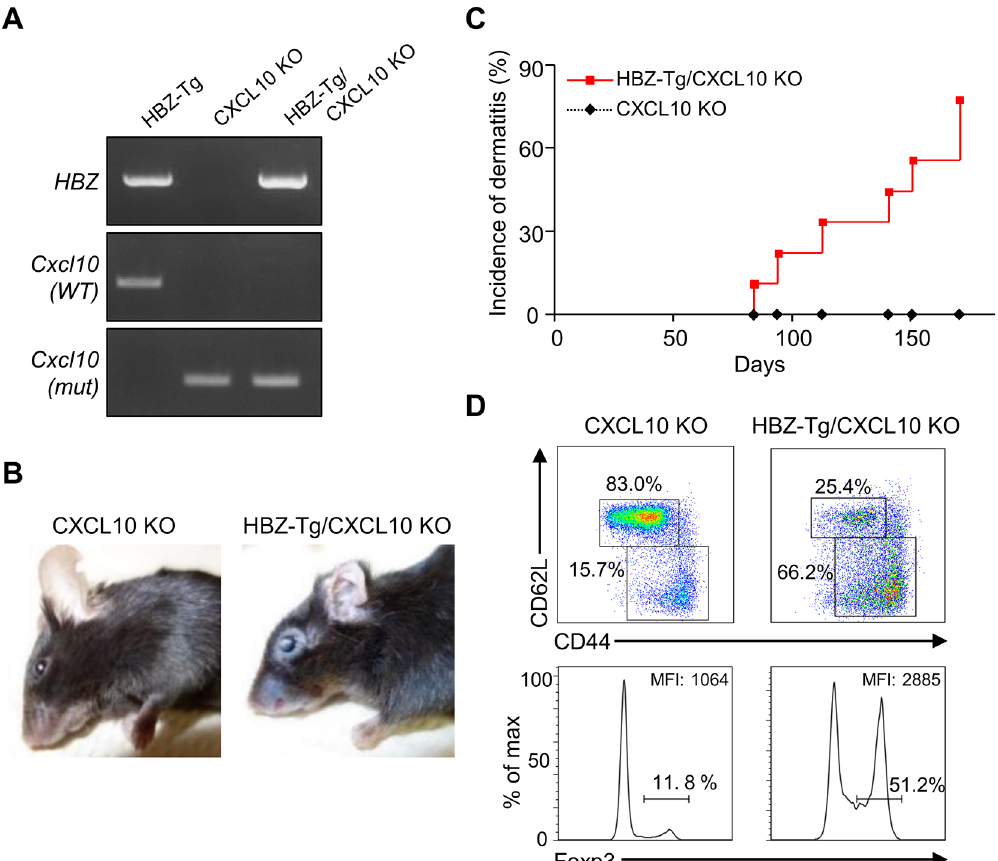
Fig 5. CXCL10 is not associated with systemic inflammation in HBZ-Tg mice. (A) HBZ-Tg and CXCL10 KO mice were crossed to establish HBZ-Tg/ CXCL10 KO mice. (B) HBZ-Tg/CXCL10 KO mice developed dermatitis. (C) At 24 weeks old, more than 50% of HBZ-Tg/CXCL10 KO mice developed dermatitis. (D) Splenocytes were obtained from CXCL10 KO mice and HBZ-Tg/CXCL10 KO mice. Cells were stained with anti-CD4, anti-CD44, anti-CD62L, and anti-Foxp3, and analyzed by flow cytometry. Among CD4 + T cells of HBZ-Tg/CXCL10 KO mice there were increased numbers of increased effector/ memory and Foxp3 expressing